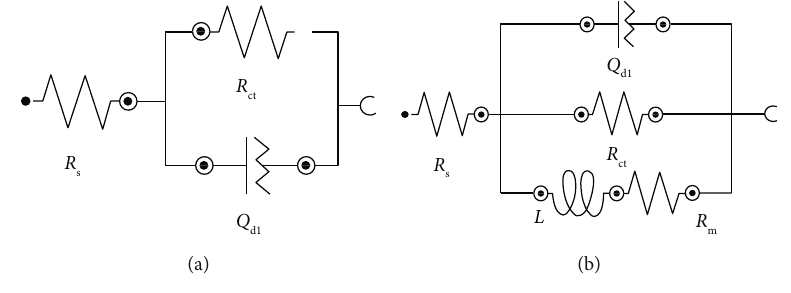
Figure 6: Equivalent circuit diagram. Table 4: Fitting data of equivalent circuit